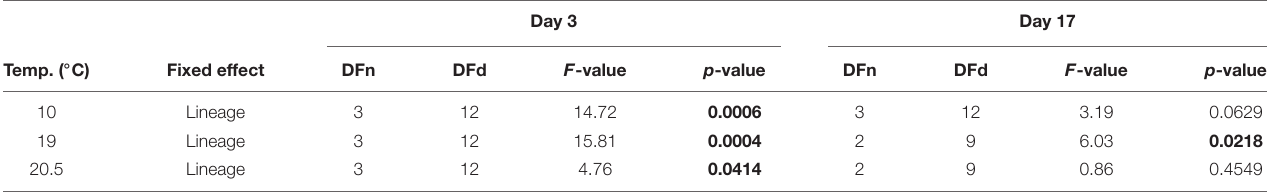
FIGURE 3 | Optimum quantum yield F v /F m of Laminaria digitata sporophytes produced by crossing females × males from Helgoland (H) and Spitsbergen (S) over time at 10 ◦ C (A) , 19 ◦ C (B) and 20.5 ◦ C (C) in experiment 2 (mean ± SD, n = 4). Significance of the fixed effect lineage on F v /F m after 3 and 17 days of temperature exposure is indicated above each panel (ANOVA; ***, p < 0.001; *, p < 0.05; n.s., not significant). For pairwise comparisons, see main text. TABLE 3 | Results of linear models to examine optimum quantum yield (F v /F m ) among lineages for two time points in the critical heat stress experiment on macroscopic Laminaria digitata sporophytes (experiment 2). Day 3 Day